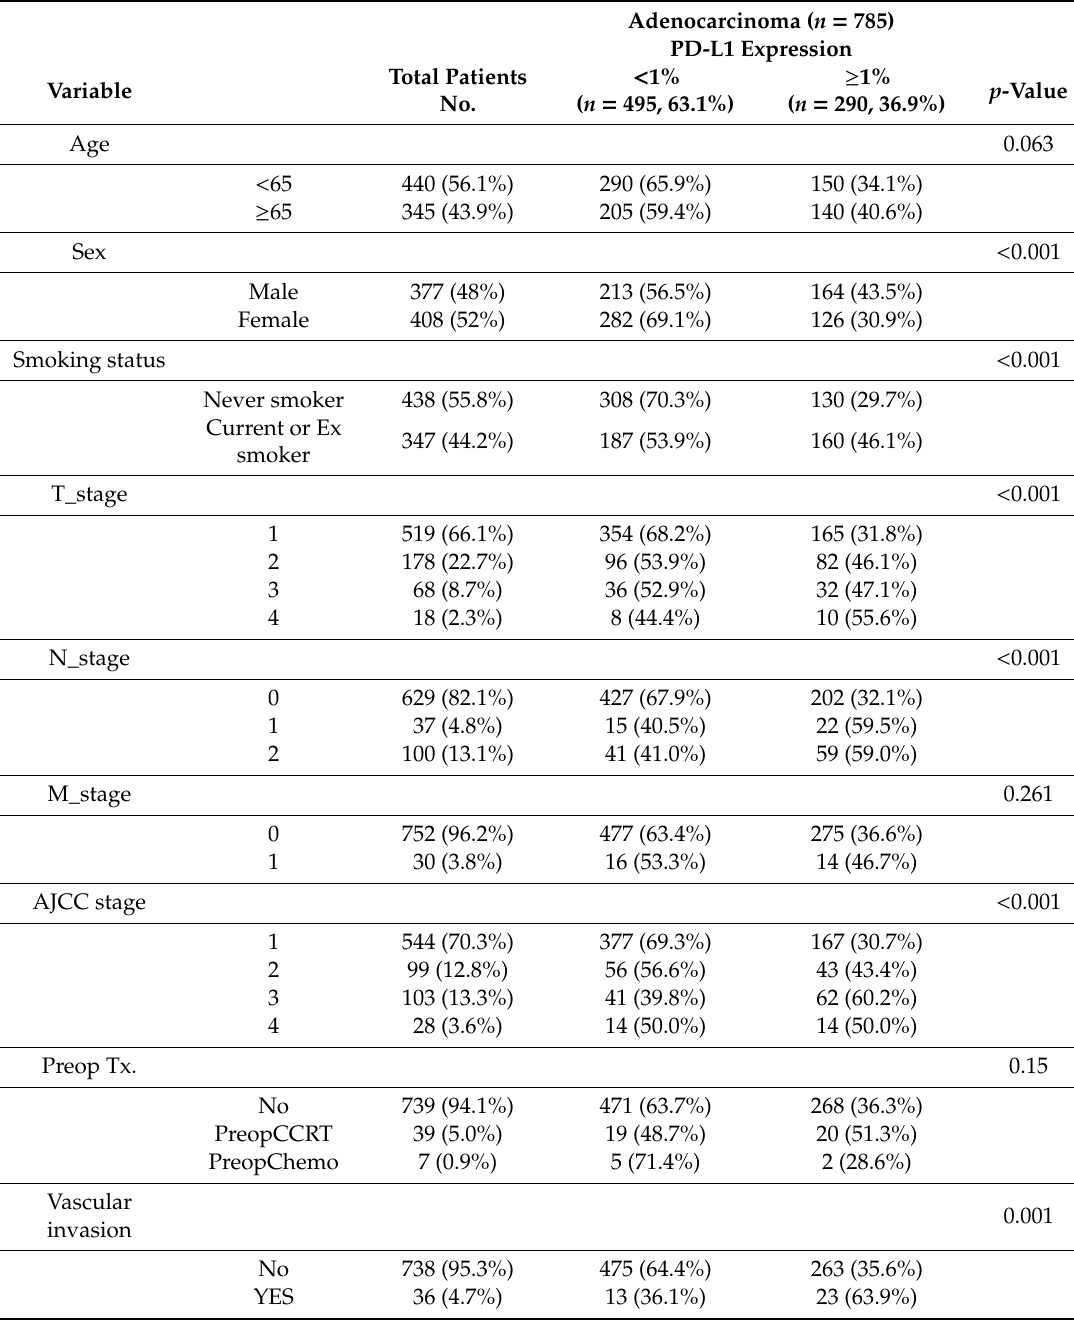
Table A1. Association between PD-L1 expression status and clinicopathological features in 785 lung adenocarcinomas (1% cuto ff